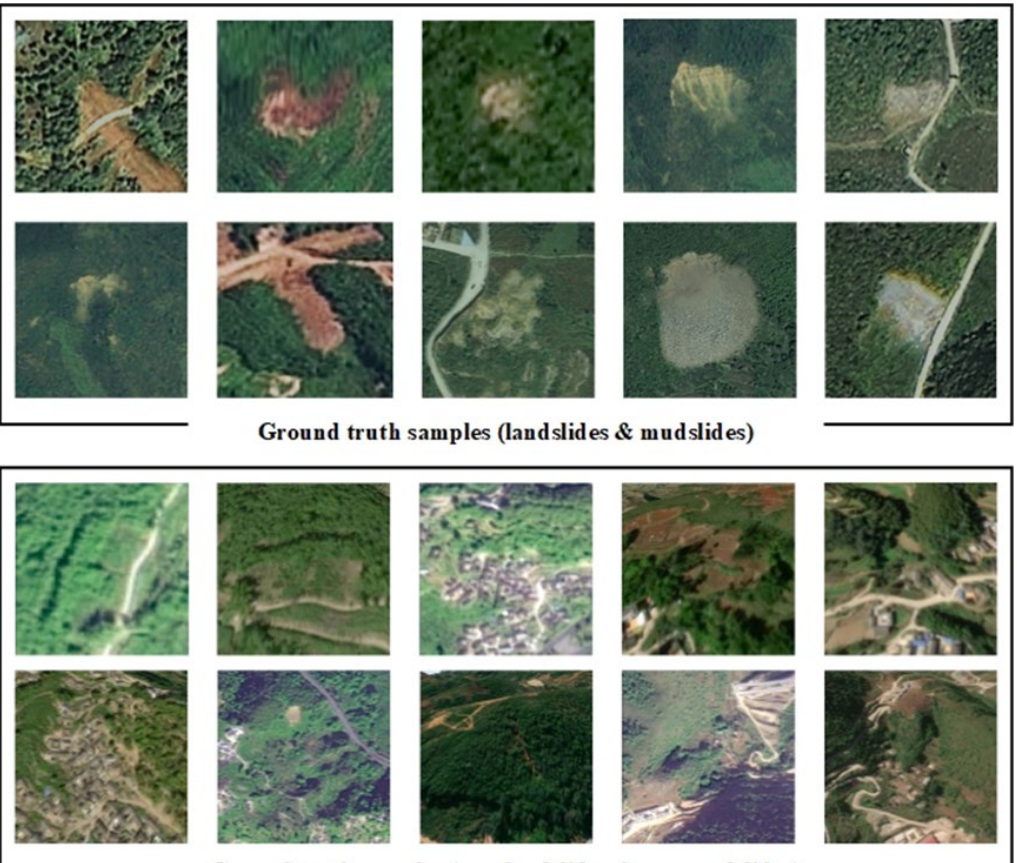
Figure 3. Selected samples of benchmark dataset. Table 1. Data augmentation.